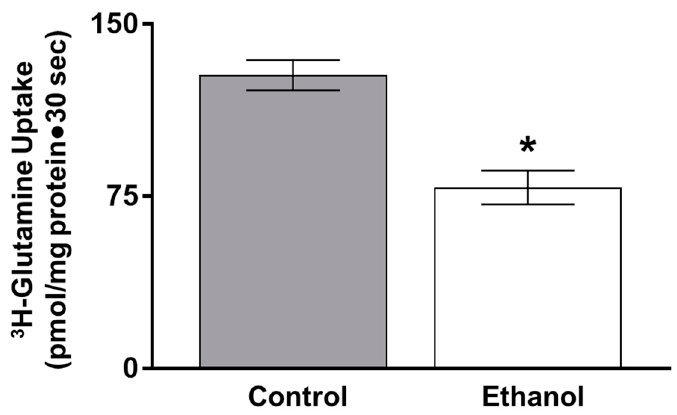
Figure 3. Moderate ethanol significantly inhibited 3 H-glutamine uptake in brush border membrane vesicles (BBMVs) from intestinal villus cells of SD rats. Sodium-dependent glutamine activity was determined using 3 H-glutamine uptakes with and without a sodium-free condition in BBMVs isolated from control and ethanol-treated rats for one hour (* p < 0.01, n = 4). The error bars represent the SEM.